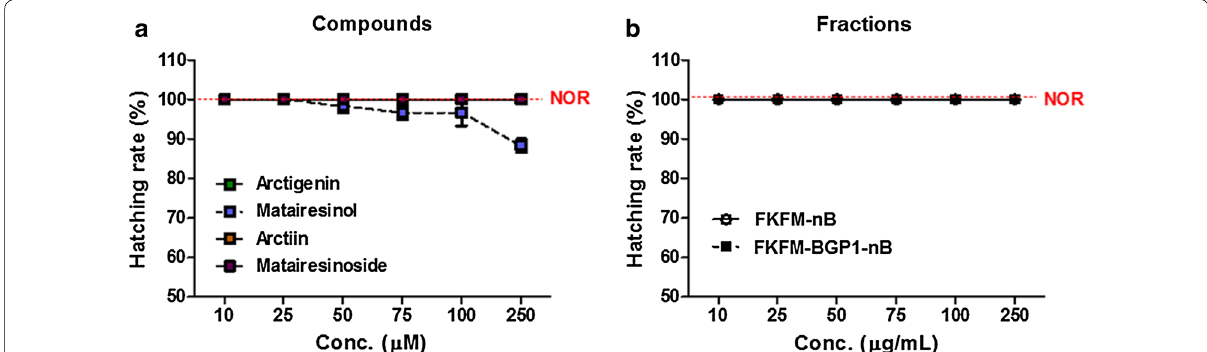
Fig. 3 Hatching rate of zebrafish embryos exposed to lignans 1–4 ( a ) and n ‑BuOH fractions (FKFM‑nB and FKFM‑BGP1‑nB) from Forsythia koreana flowers for 72 h ( b ). FKFM‑nB and FKFM‑BGP‑1‑nB were obtained by extraction of both MeOH extracts using n ‑BuOH